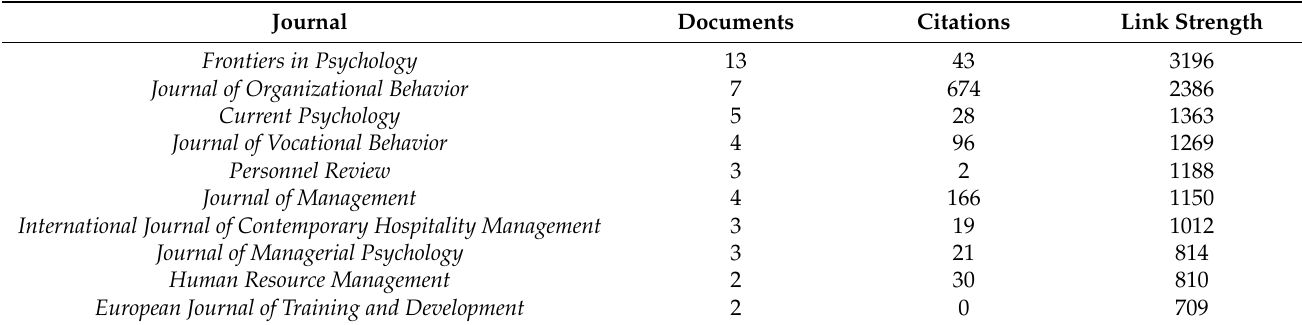
Table 9. Bibliographic coupling of journals.